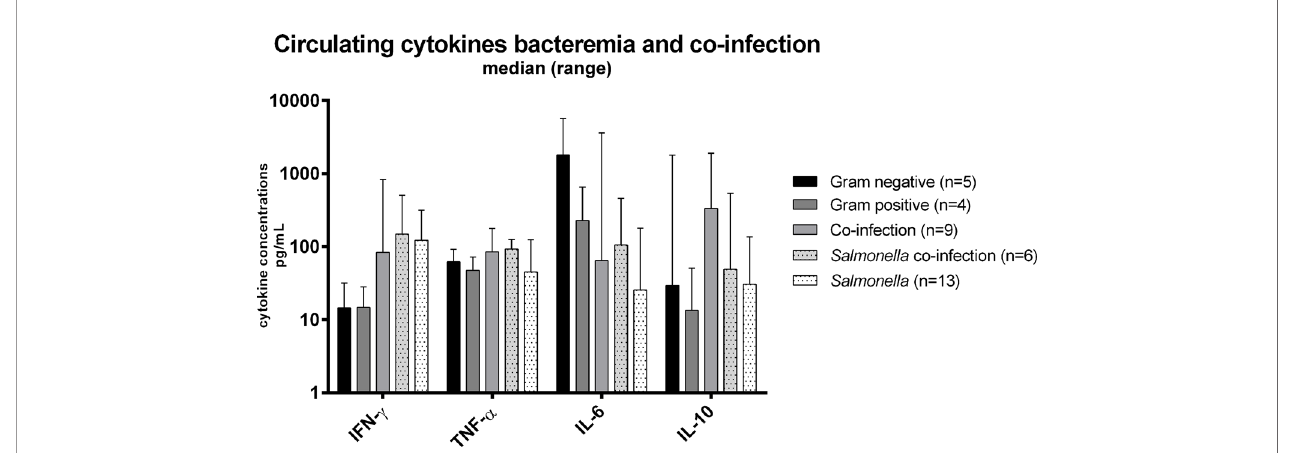
FIGURE 3 | Circulating cytokine concentrations among patients below fi ve years old with blood culture con fi rmed bacteremia (Gram positive, Gram negative, Salmonella ) and malaria-bacteremia co-infection. Legend | Cytokine concentrations reported in